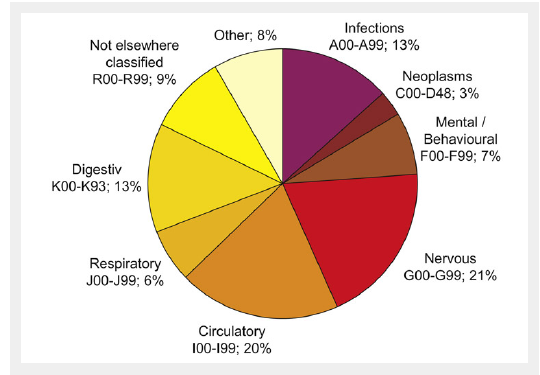
Distribution of ICD 10 coded diagnoses. Selection of ICD10 chapter took place during intershift handover session by the observing